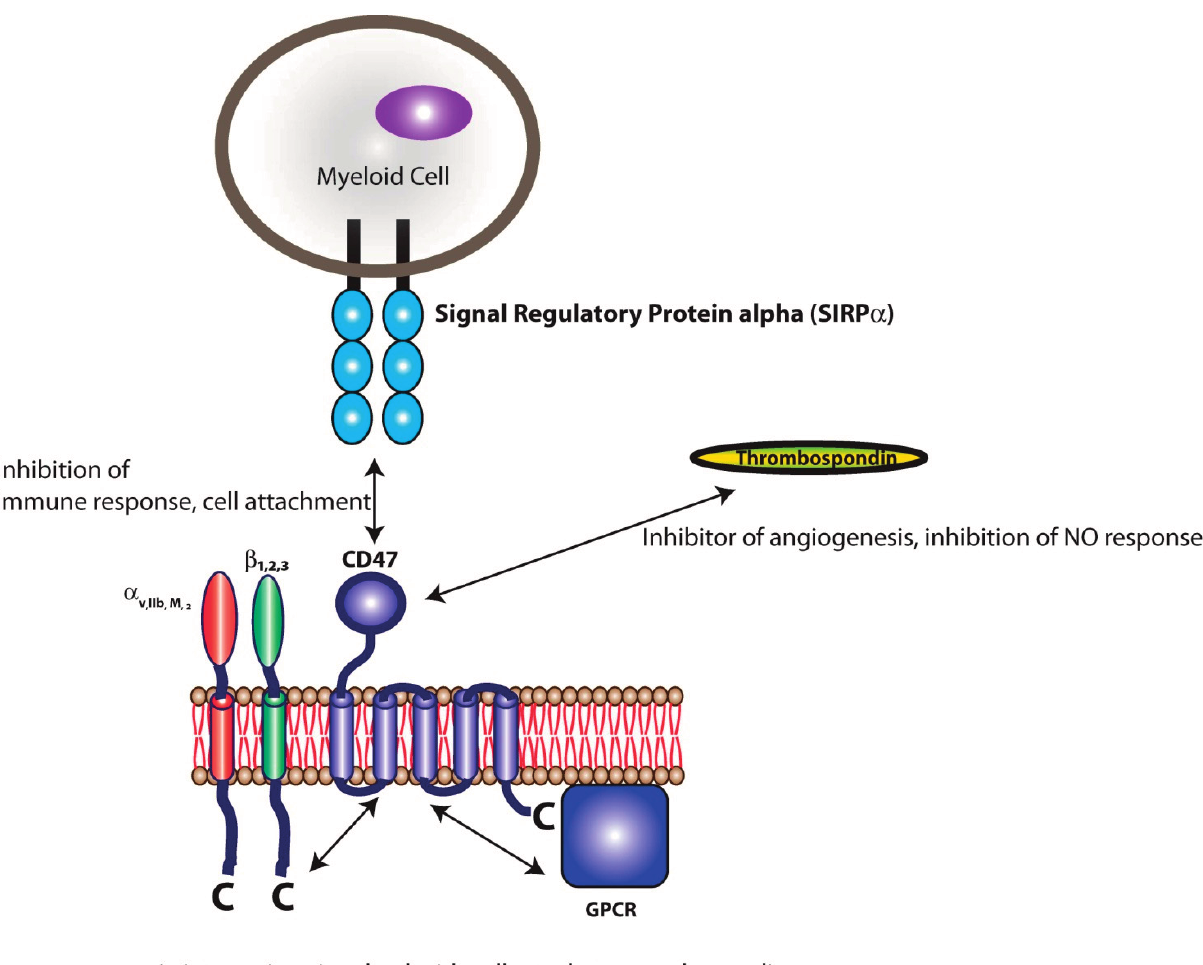
Figure 2. CD47 binding partners. CD47 is a transmembrane protein with an N -terminal extracellular IgV-like domain, 5 transmembrane domains, and a short C -terminal cytoplasmic tail. Well-characterized interactions with CD47 include: cis interactions with integrins, trans interactions with thrombospondin, and trans interactions with SIRP α